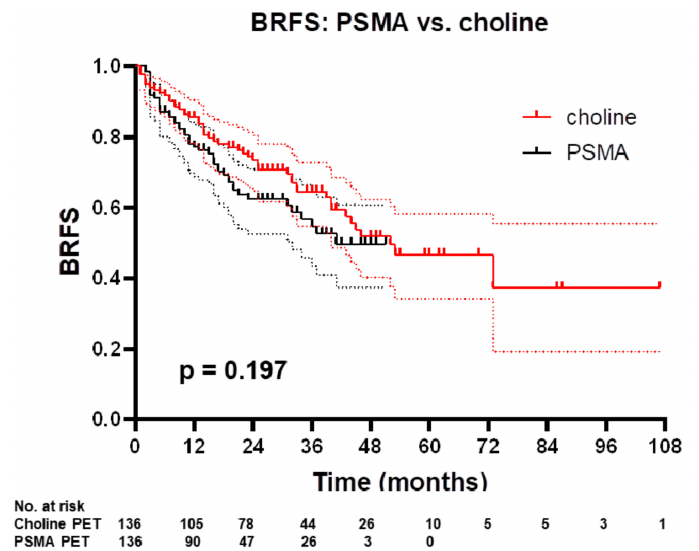
Figure 3. Kaplan–Meier curve of BRFS PSMA vs. choline PET in adjusted cohorts. Plotted symbols represent censored points. Error bars show 95% confidence interval. p value was obtained with log-rank